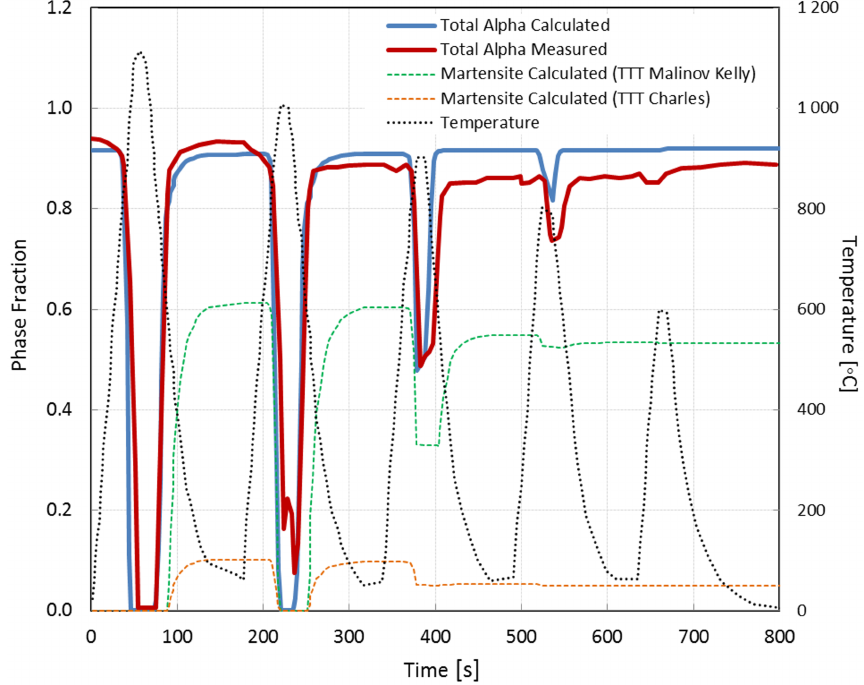
Figure 11. Successive cycles of metal deposition. Evolution of temperature and of total alpha fraction measured by Babu [29]. Evolution of total alpha and martensite fractions calculated with the present model.